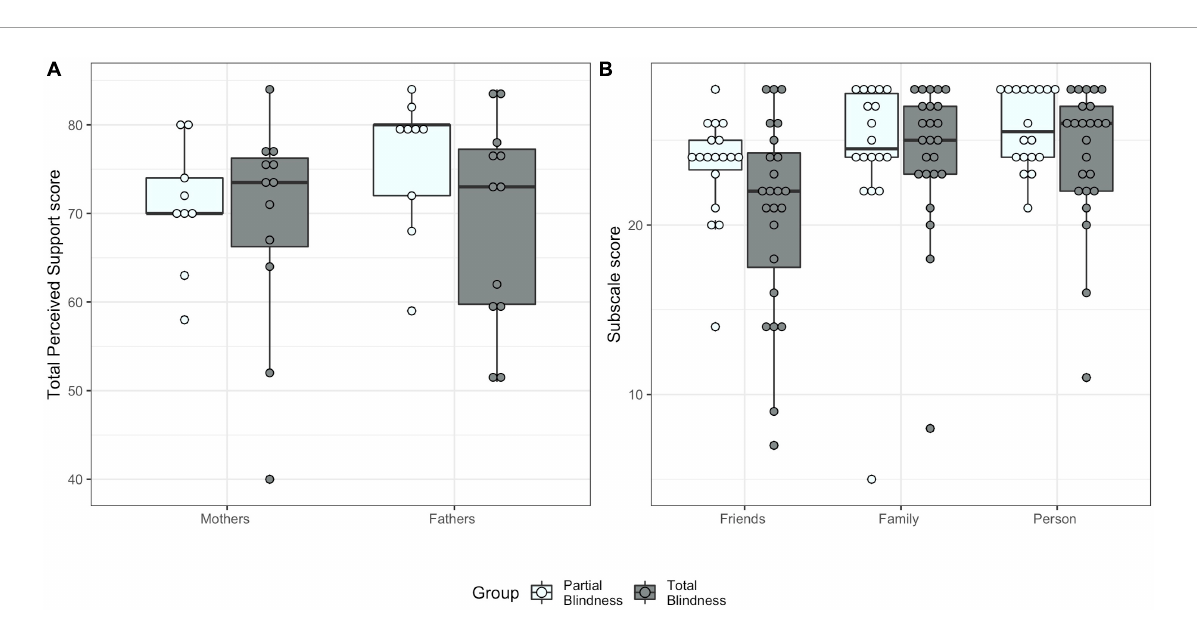
FIGURE2 Multidimensional Scale of Perceived Social Support scores by blindness group. (A) Total Perceived Social Support score for mothers and fathers. (B) Scores for the three subscales (Support by Friends, Support by Family, Support by Significant Other